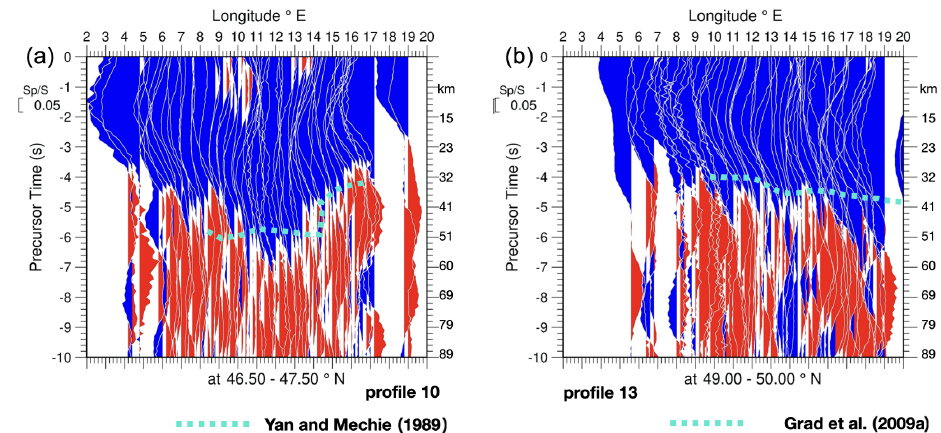
Figure 20. (a) Copy of profile 10 (Fig. 12a) with results of Yan and Mechie (1989), who used data from a refraction profile along the Alpine chain. (b) Additional east–west profile well north of the earlier profiles shown, constructed for comparison with the Moho map of Grad et al. (2009a) and comparison with profile 10 of Fig. 20a. Note the substantial difference in Moho depth between our data east of 14 ◦ E and those of Grad et al. (2009a). Also note that we see pronounced Moho deepening towards the east in this northerly located profile located in the European lithosphere, which contrasts with Moho shallowing towards the east in the southern profile of Fig. 20a located in the Pannonian region (see Fig. 2 for the location of the